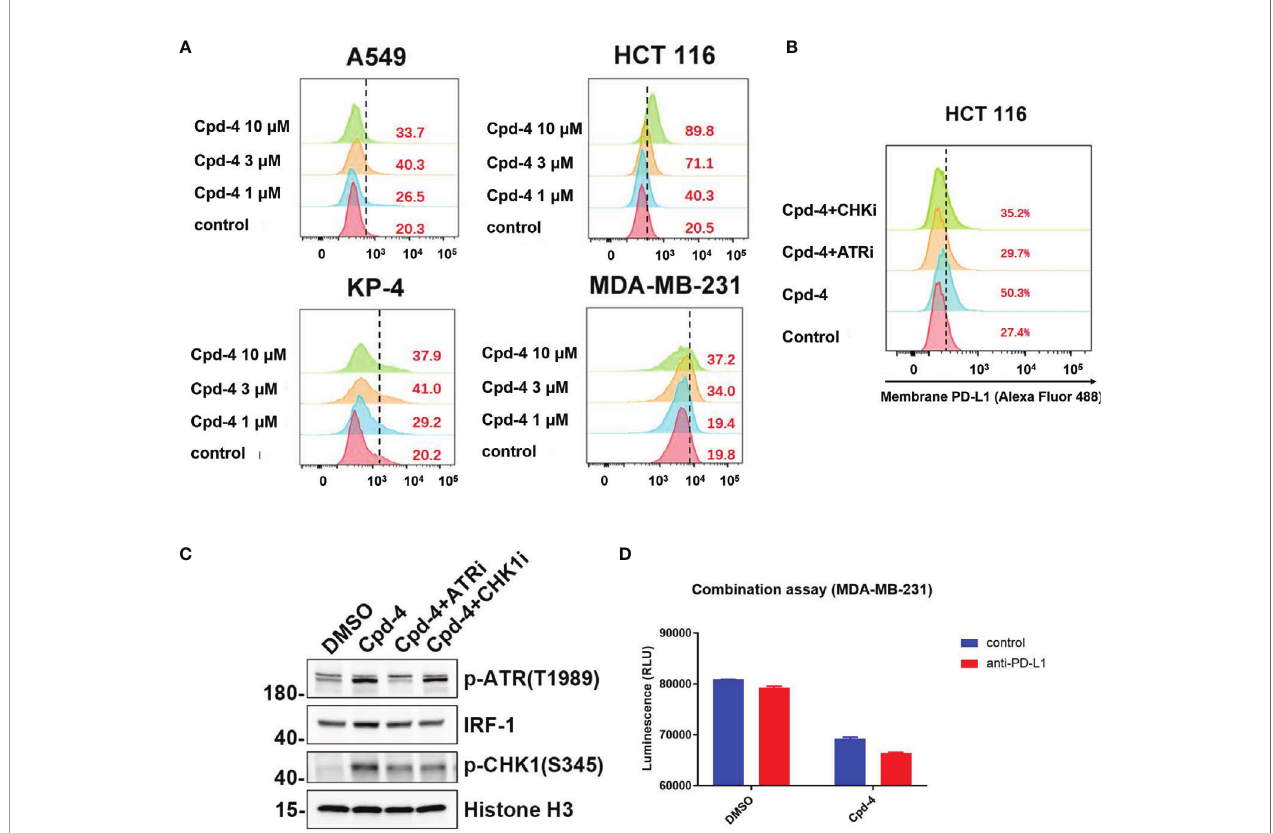
FIGURE 6 | RAD51 inhibition induces PD-L1 upregulation and shows potential for combination with PD-L1 immune checkpoint blockade. (A) RAD51 inhibitor upregulates PD-L1 expression in various cell lines. MDA-MB-231, A549, KP-4 and HCT 116 cells were treated with indicated concentration of Cpd-4 for 24 h, and cell surface PD-L1 was analyzed by fl ow cytometry. (B) RAD51 inhibition induced PD-L1 expression depends on the activity of ATR-Chk1 signaling. HCT 116 cells were treated with ATRi (AZD6738, 10 m M) or Chk1i (MK8776, 1 m M) inhibitor 1 h prior to RAD51 inhibitor (Cpd-4, 2 m M) treatment. Cell surface PD-L1 expression was examined after 24 hours. (C) ATR-Chk1 signaling promotes IRF-1 expression after RAD51 inhibition in HCT 116 cells. Cells were treated with DMSO, ATRi or CHKi for 2 hours and then treated with DMSO or Cpd-4 for 4 h. The levels of p-ATR, IRF1 and p-Chk1 were examined by western blot after indicated compound treatment. (D) Quantitation showing cell viability following treatment with Cpd-4 (10 m M), PD-L1 antibody (PD-L1 Ab; 10 mg/mL), or the combination cocultured with activated PBMCs for 72 hours. Cell viability were determined with CellTiter-Glo